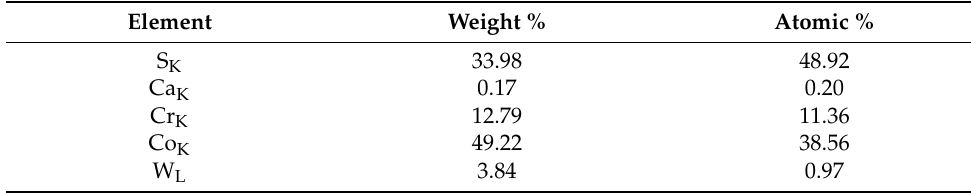
Table 4. Quantitative composition of one of the dark areas.